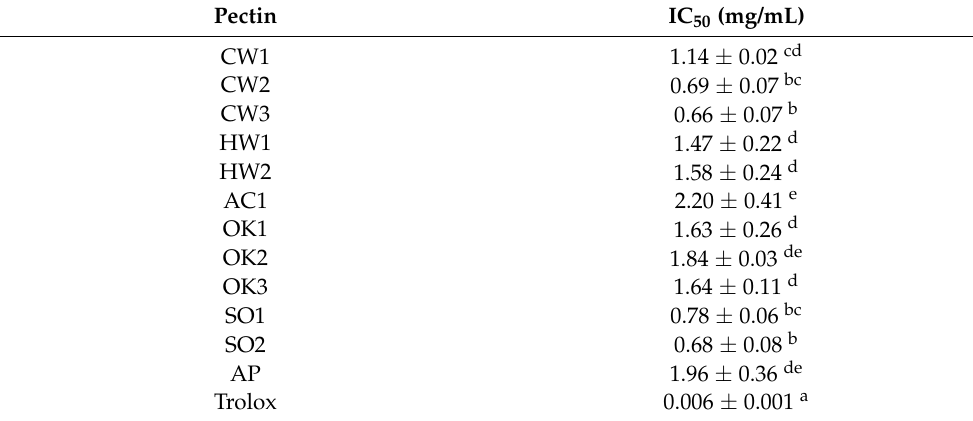
Table 3. DPPH scavenging effect of polysaccharide fractions from S. passerine . Pectin IC 50 (mg/mL)